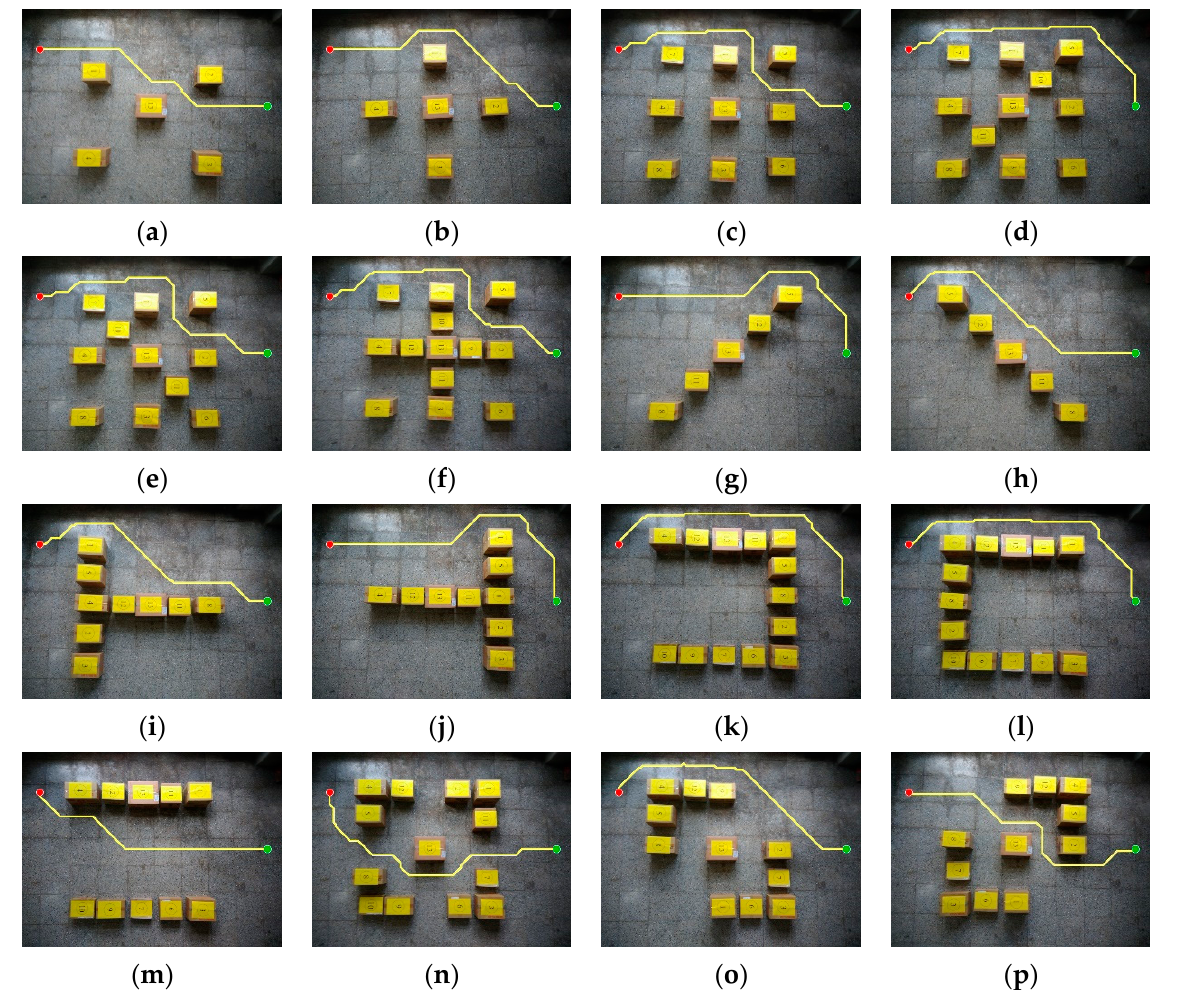
Figure 21. Planned paths shown in Experiment II: ( a ) result #1; ( b ) result #2; ( c ) result #3; ( d ) result #4; ( e ) result #5; ( f ) result #6; ( g ) result #7; ( h ) result t #8; ( i ) result #9; ( j ) result #10; ( k ) result #11; ( l ) result #12; ( m ) result #13; ( n ) result #14; ( o ) result #15; ( p ) result #16.